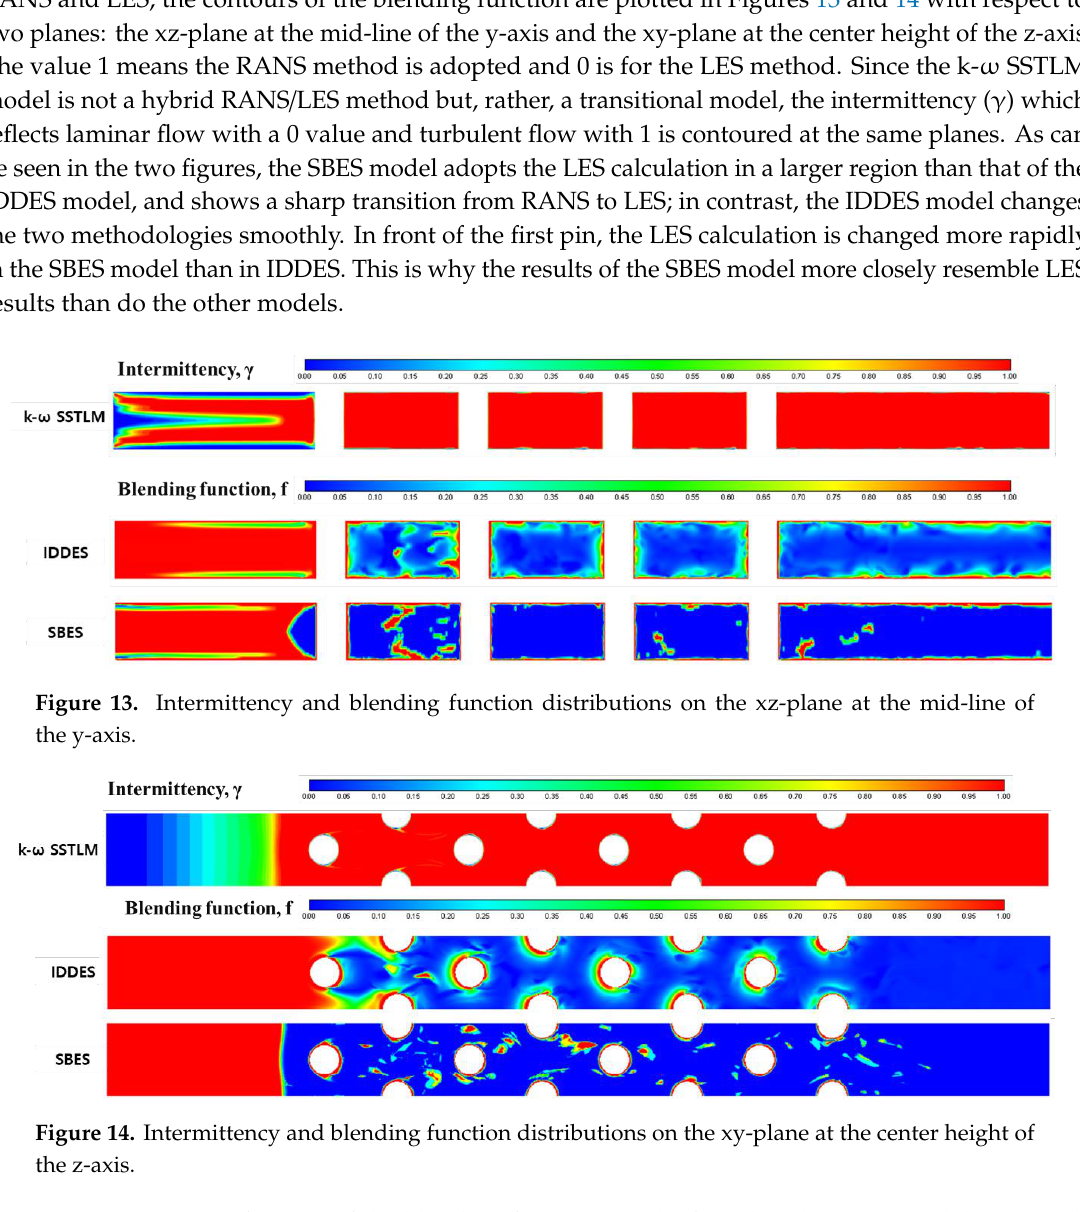
Figure 12. Time-averaged streamlines colored by T ave in front of the first row of pins. HV, horseshoe vortex; SV, secondary vortex; TV, tertiary vortex; CV, corner vortex.